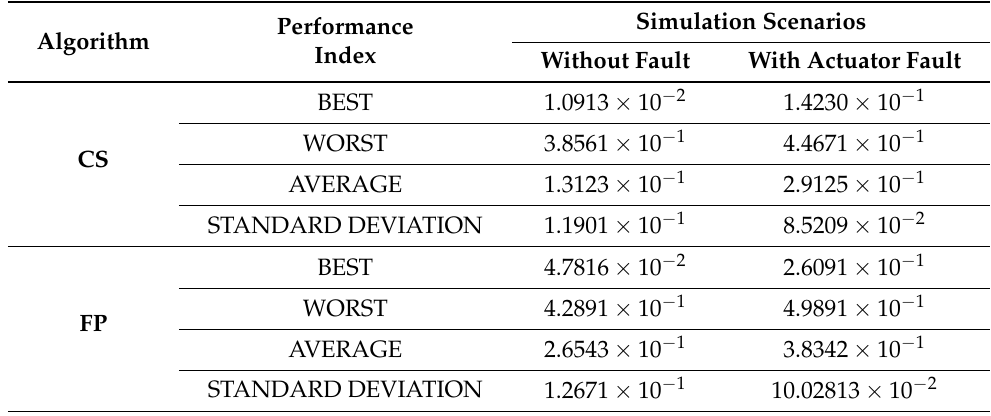
Table 4. Results of metrics of Root Mean Square Error (RMSE) values to found by CS and FP algorithm using